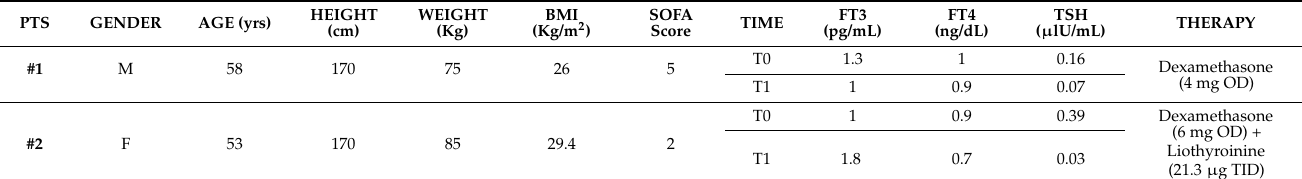
Table 2. Epidemiological and clinical characteristics of two COVID-19 patients in the pilot